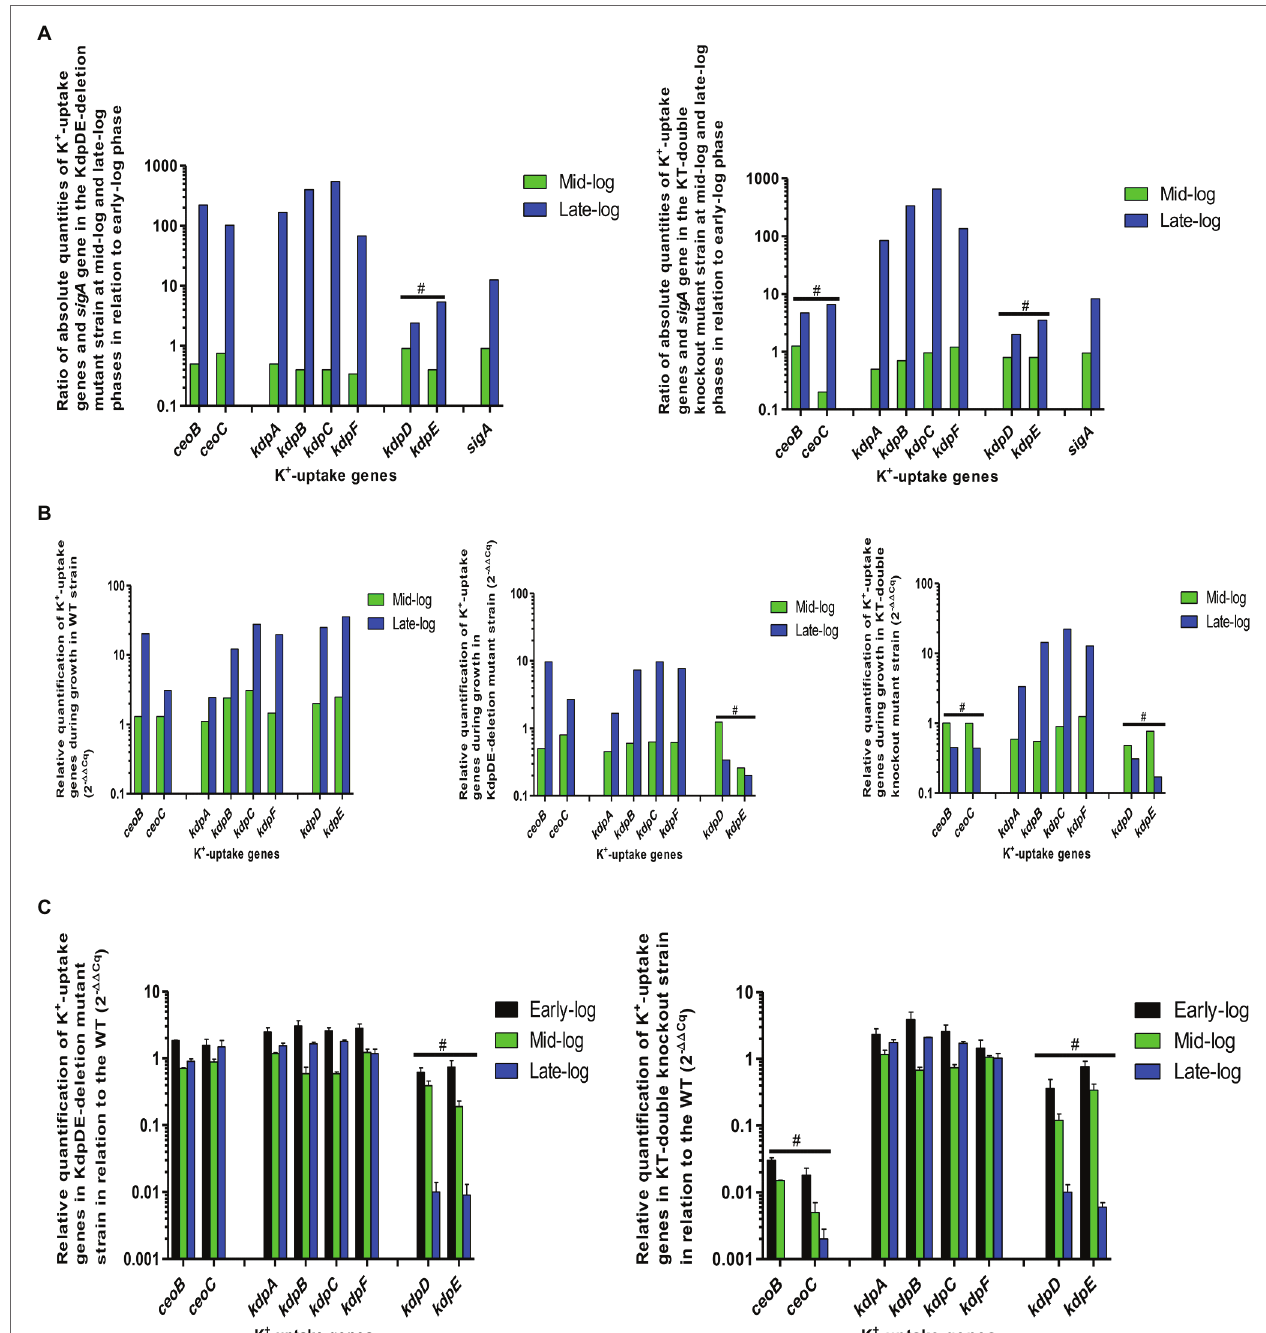
FIGURE 5 | Gene expression measured during the various phases of bacterial growth for the WT and mutant strains. (A) Ratio of gene expression of absolute quantities of the K + -uptake genes and the sigA gene in the mutant strains during growth at mid- and late-log phases in relation to early-log phase, (B) relative quantification of K + -uptake genes in the mutant strains during growth relative to early-log phase (2 −ΔΔ Cq ), and (C) relative quantification of K + -uptake genes in mutant strains relative to the WT (2 −ΔΔ Cq ). # represents mutations of the individual